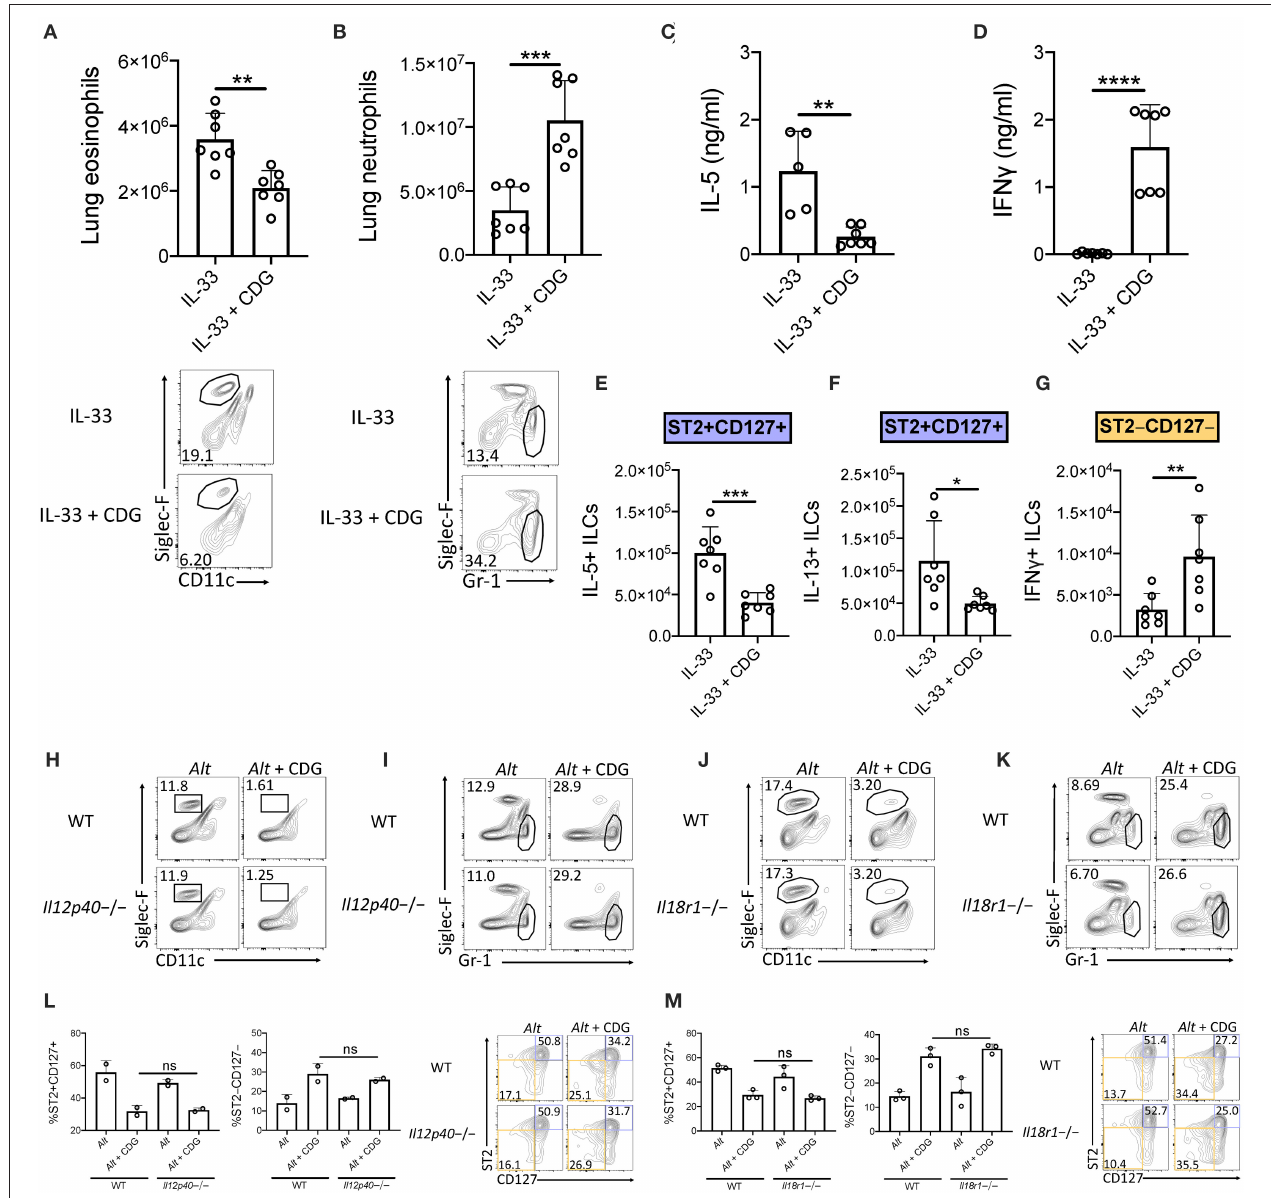
FIGURE 3 | Suppression of type 2 inflammation occurs downstream of IL-33 and is independent of IL-12 and IL-18 signaling. (A–G) Mice were challenged using the same model as in Figure 1A but with IL-33 instead of Alt . (A) Total lung eosinophils (top) and representative flow plots (bottom). (B) Total lung neutrophils (top) and representative flow plots (bottom). BAL IL-5 (C) and IFN γ (D) ELISA. Total number of IL-5 + lung ILC2s (E) , IL-13 + lung ILC2s (F) , and IFN γ + lung ILC1s (G) following PMA/ionomycin stimulation ex vivo . (H–M) Mice were challenged using the same model as in Figure 1A . Il12p40 -/- lung eosinophil (H) and neutrophil (I) frequencies and Il18r1 -/- lung eosinophil (J) and neutrophil (K) frequencies. Data shown are representative of two independent experiments with 2–4 mice per group. * P < 0.05, ** P < 0.01, *** P < 0.001, **** P < 0.0001, unpaired t